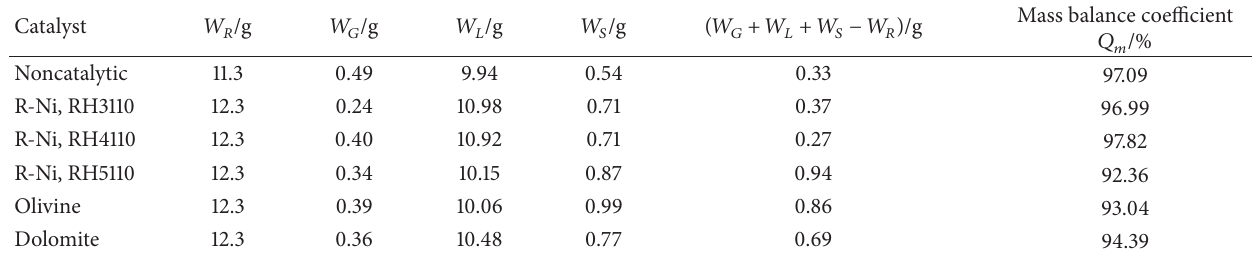
Table 5: Mass balance for heterogeneous catalyst investigation.